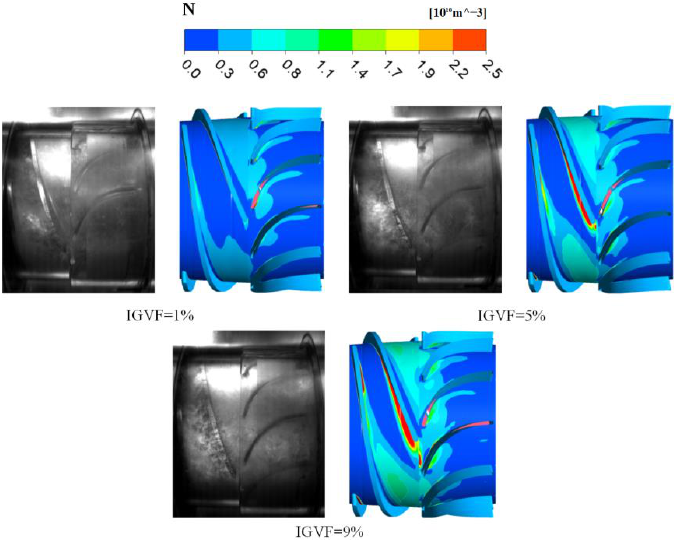
Figure 7. Comparison of experimental and numerical simulation results.